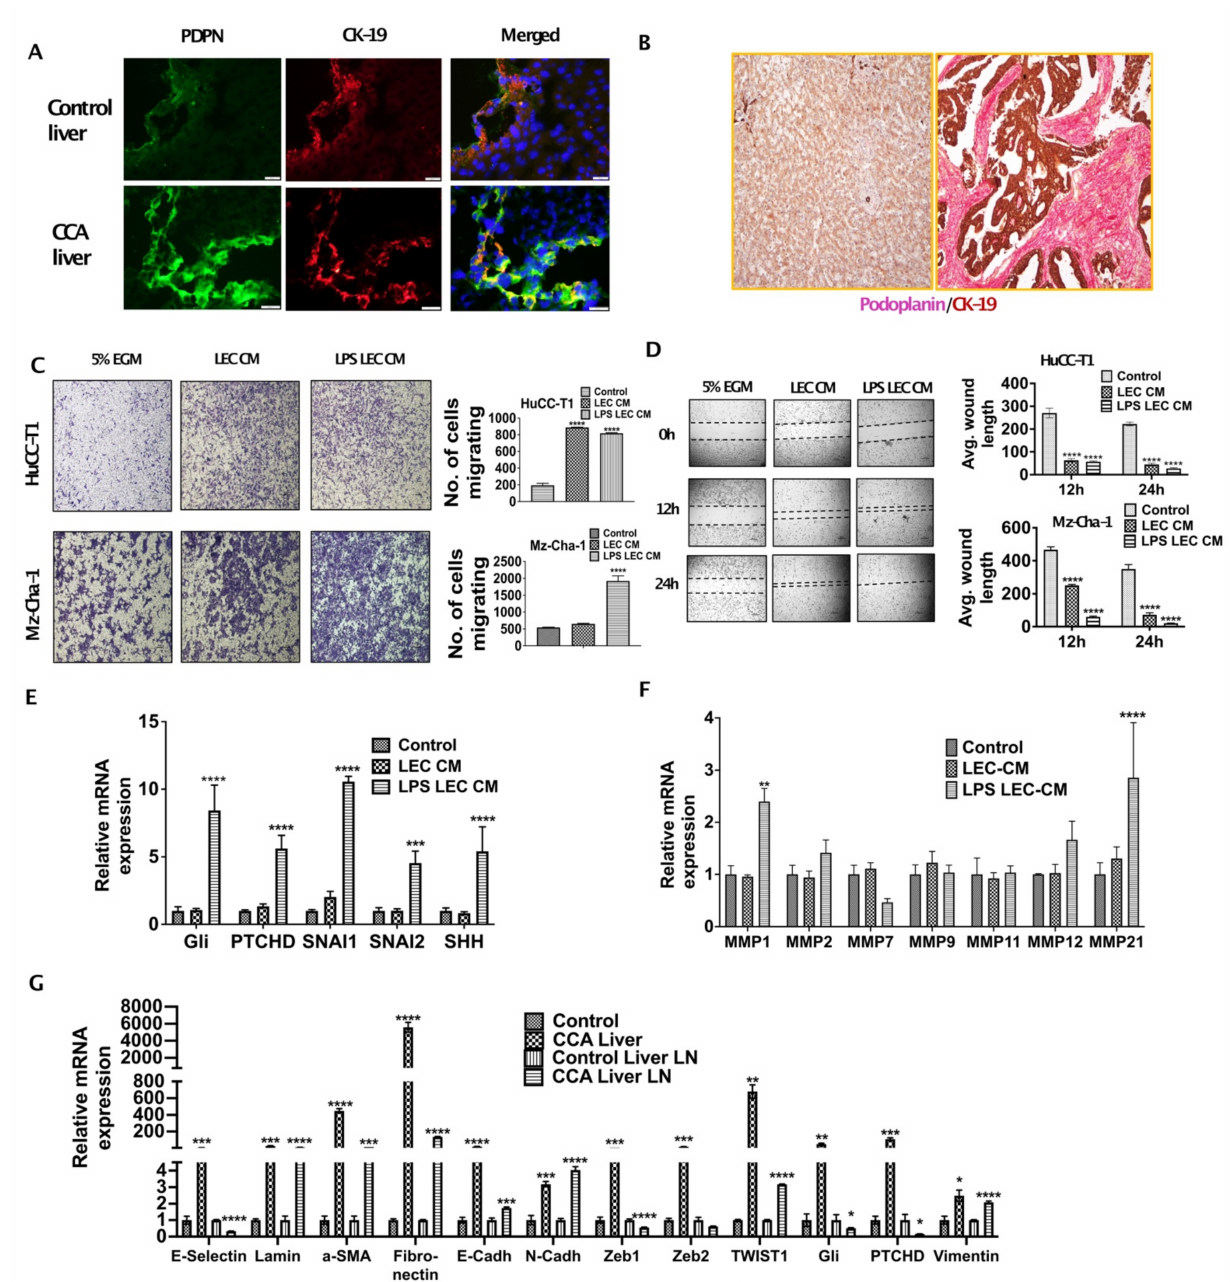
Figure 1. Inflamed LECs enhance tumor migration and activation of critical EMT regulators in CCA. ( A ) Orthotopic syngeneic tumors exhibit increased intratumoral lymphatics. Representative immunofluorescence (IF) images at 40 × of Podoplanin expression (green fluorescence) and cytokeratin19 (CK-19, red fluorescence) with DAPI in tumor tissues from orthotopic syngeneic CCA mice (SB1). Scale bar is 20 µ m. At least 3–5 images were taken for all tissue sections. ( B ) CCA patients have increased lymphatic invasion in tumor tissues. Representative immunohistochemistry images at 20